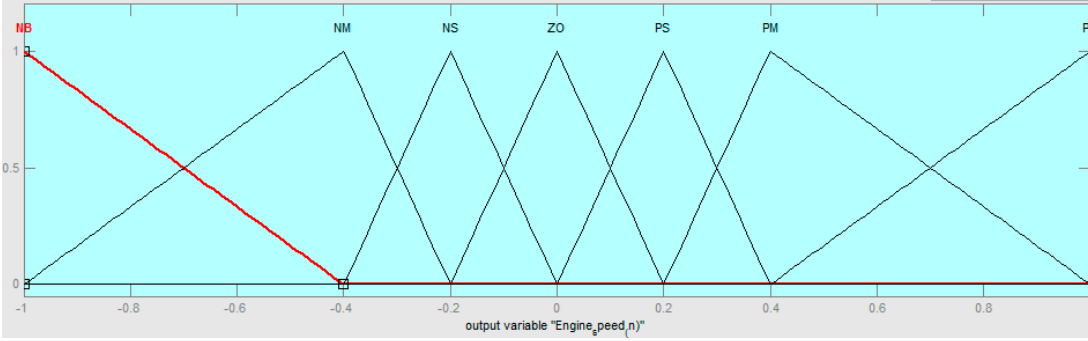
Figure 15. Diesel engine speed output (n) optimized by PSO.